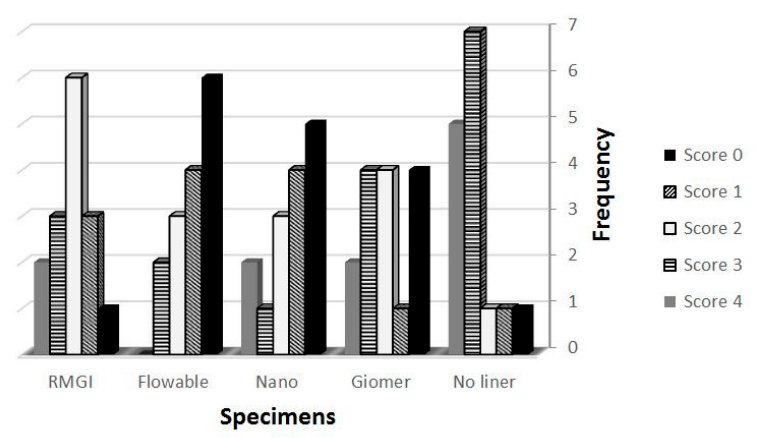
Figure 3. The frequency of microleakage scores in the specimens of group B. Table 1. Comparison of microleakage score between counterpart subgroups using Mann–Whitney test.